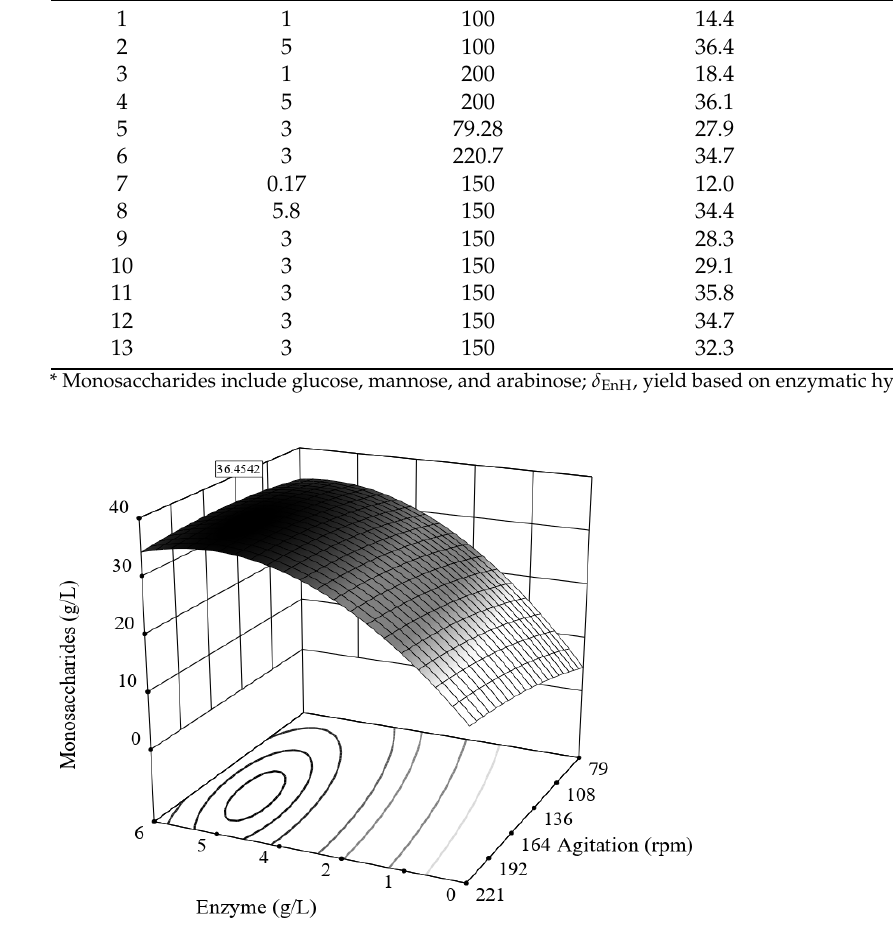
Figure 2. Surface response plot for enzymatic hydrolysis of bored coffee beans. Table 3. Central composite design for enzymatic hydrolysis, concentration of monosaccharides, and yield.